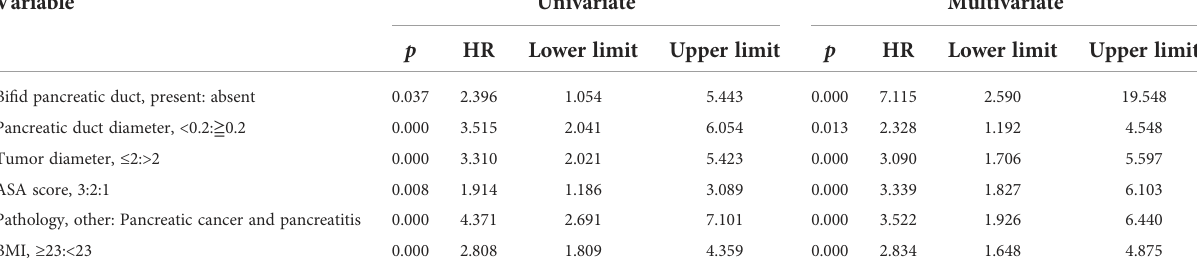
TABLE 3 Univariate and multivariate factor